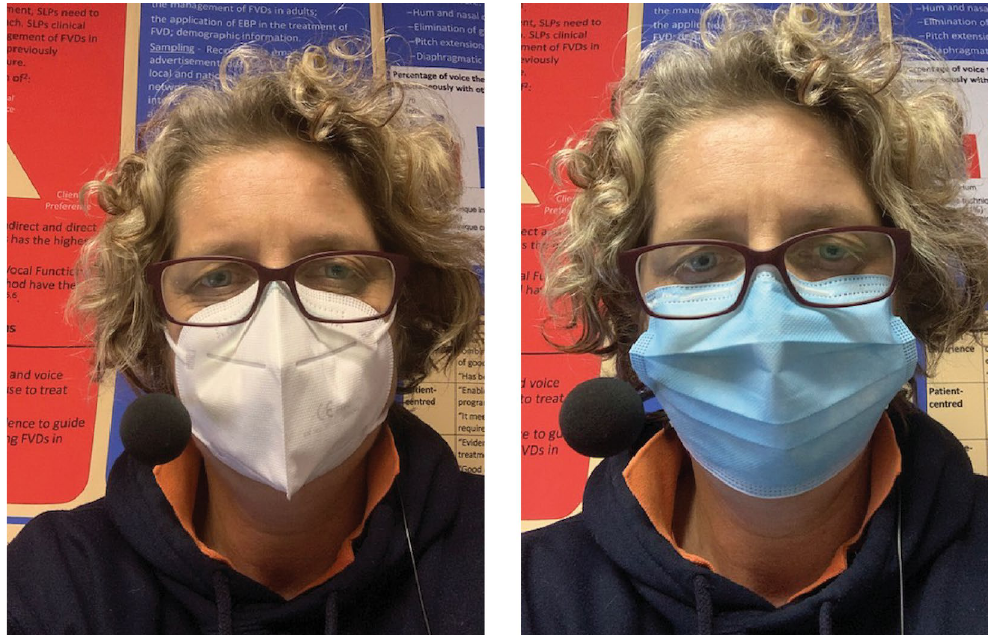
Figure 1. Voice recording with a KN95 (left) and surgical mask